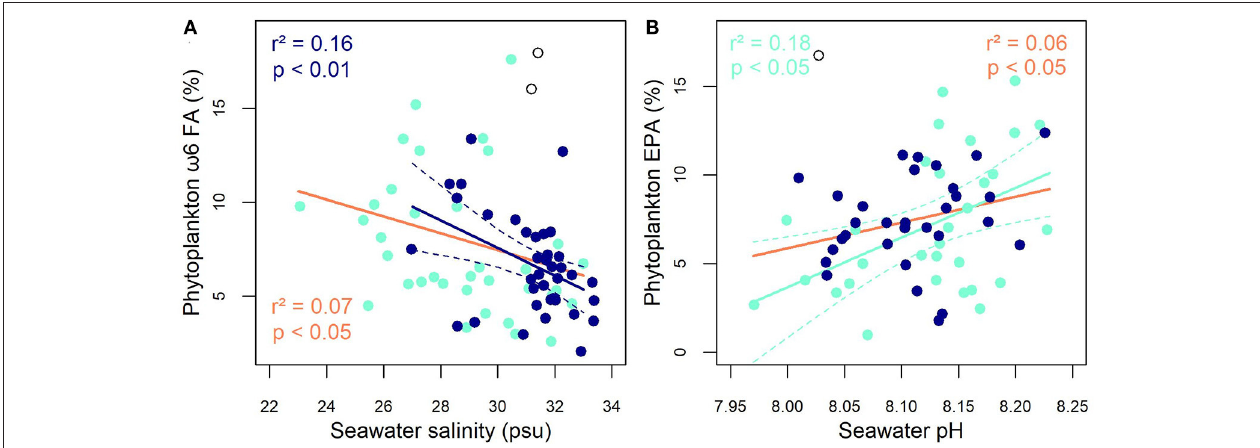
FIGURE 5 | Significant relationships between (A) ω 6-FA proportion and salinity, and (B) EPA proportion and seawater pH. The dark-blue symbols, lines and text represent the subsurface chlorophyll maximum (SCM), the turquoise symbols, lines and text represent the surface (SUR) and the orange lines and text represent the SCM and SUR combined. The dashed line represents the 95% confidence interval and open circles represent outliers in the SCM dataset (Grubbs test, p < 0.05).